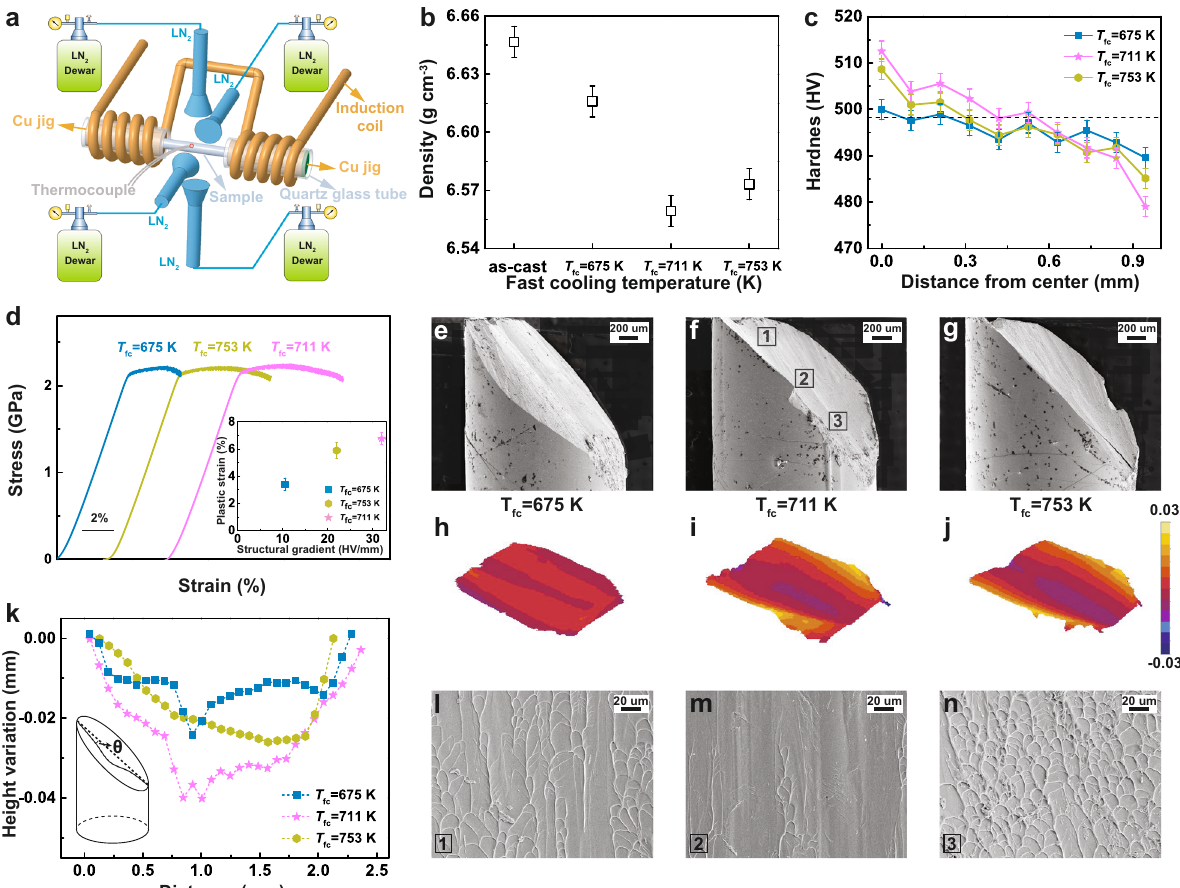
Fig. 4 Preparation and mechanical behaviors of the GMG with soft shell and hard core. a Schematic setup of fast cooling device used. b Density values of the as-cast and fast-cooled bulk MGs. The error bars were obtained by standard deviation from 15 independent density measurements. c Variation of average hardness value along with the distance from the center in the samples fast-cooled at different temperatures. The error bars were obtained by standard deviation from fi fteen independent measurements of hardness. d Mechanical properties of fast-cooled Zr 58 Cu 22 Fe 8 Al 12 MGs subjected to uniaxial compression. The inset shows the variation of the plastic strain with the structural gradient. The vertical error bars represent standard deviation from four independent measurements of plastic strain. The horizontal error bars indicate the standard deviation of structural gradient according to the hardness value. e – g Lateral morphologies of the fractured fast-cooled GMG samples. h – j The corresponding 3D contours of the fracture surfaces. High and low contours were coloured in yellow and blue. k Height variation pro fi les of the middle line along the shear band plane for fast-cooled GMG samples. l – n SEM surface morphologies at positions 1 – 3 in the T fc = 700 K sample ( f